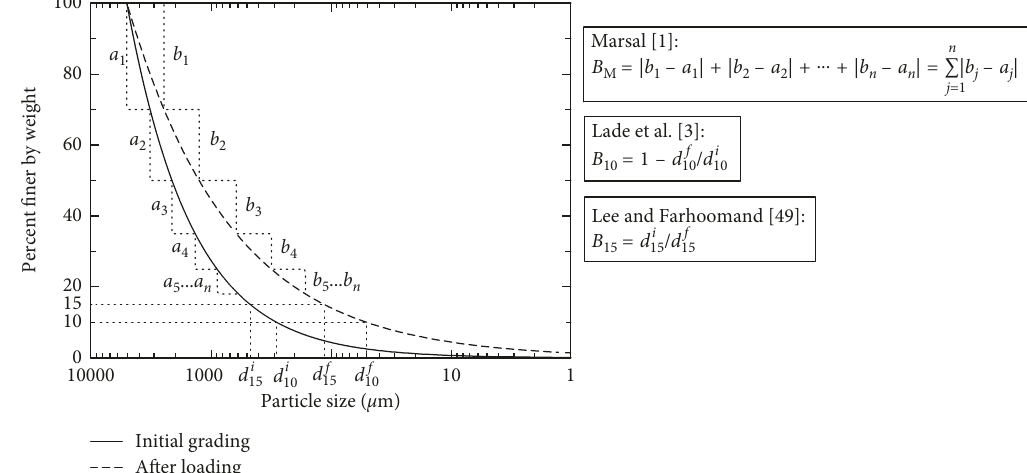
Figure 8: Definitions of the particle crushing indexes B